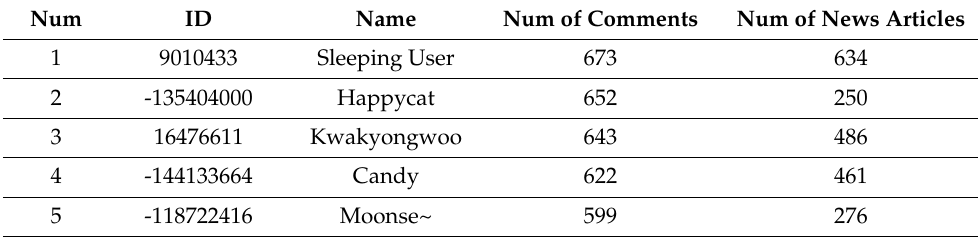
Table 3. User data for top 5